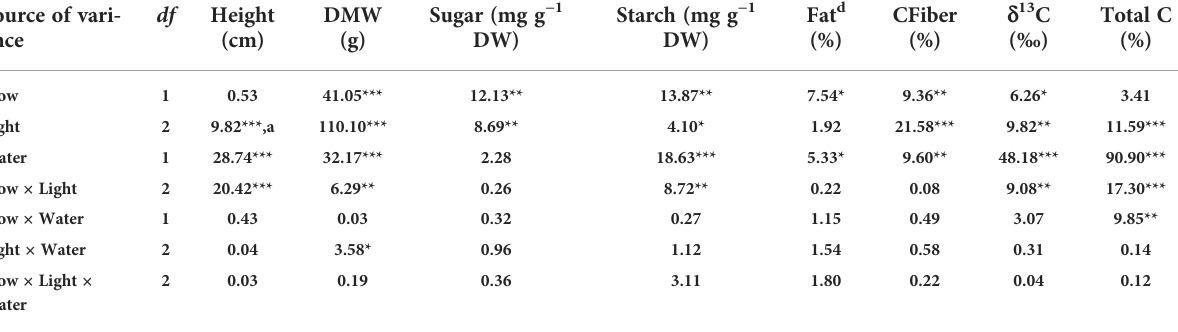
TABLE 1 F -values from analysis of variance (ANOVA) of shoot-mowing (Mow), light-emitting diode (LED) spectra (Light), moist condition (Water), and their inter- and multicombinations on growth, biomass, and carbon (C) metabolism in alfalfa ( Medicago sativa L.) seedlings. Source of